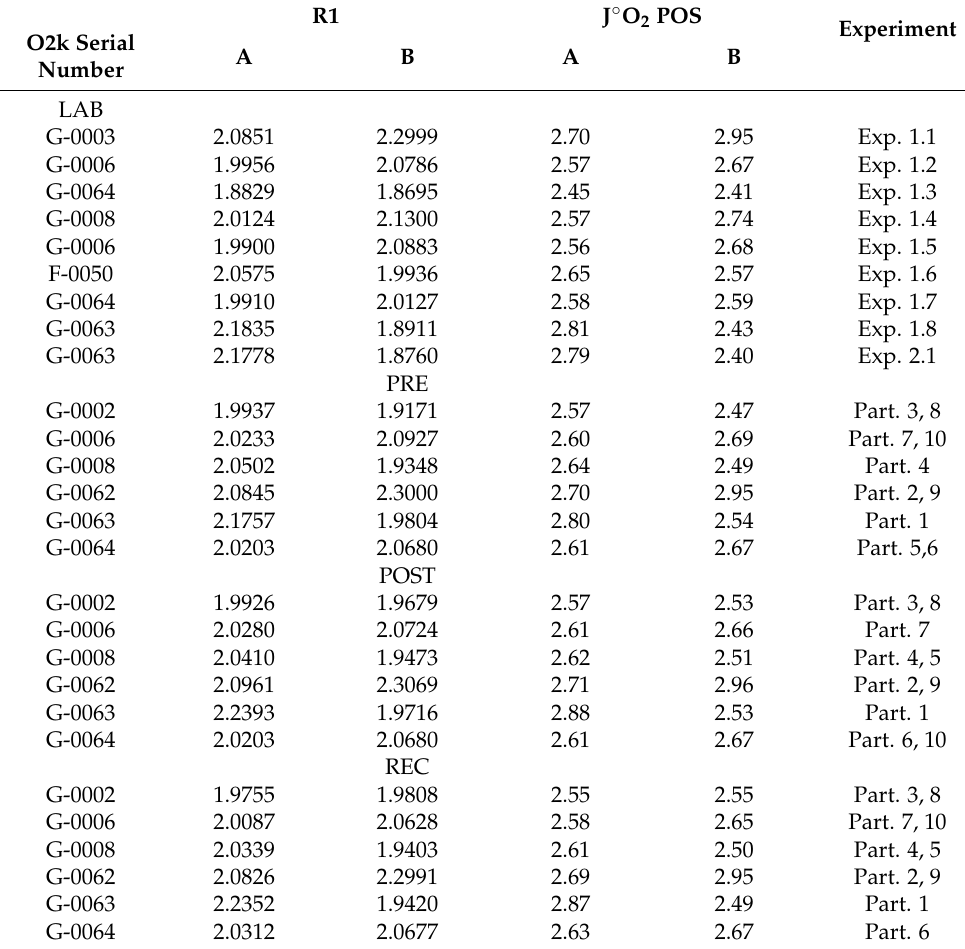
Table A2. POS sensor calibration in LAB and ultramarathon